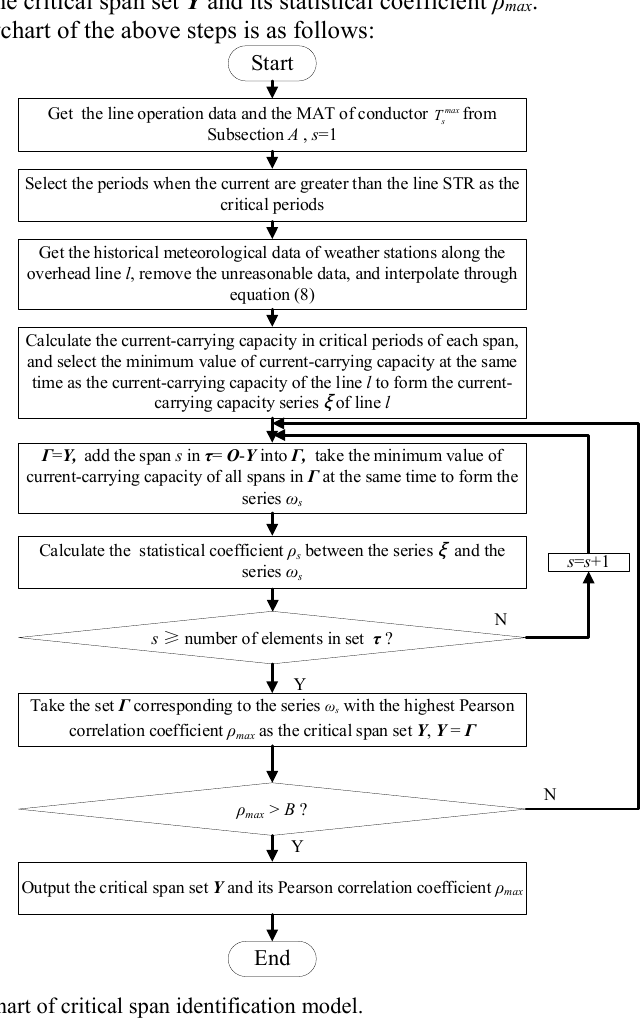
Fig. 2. Flowchart of critical span identification